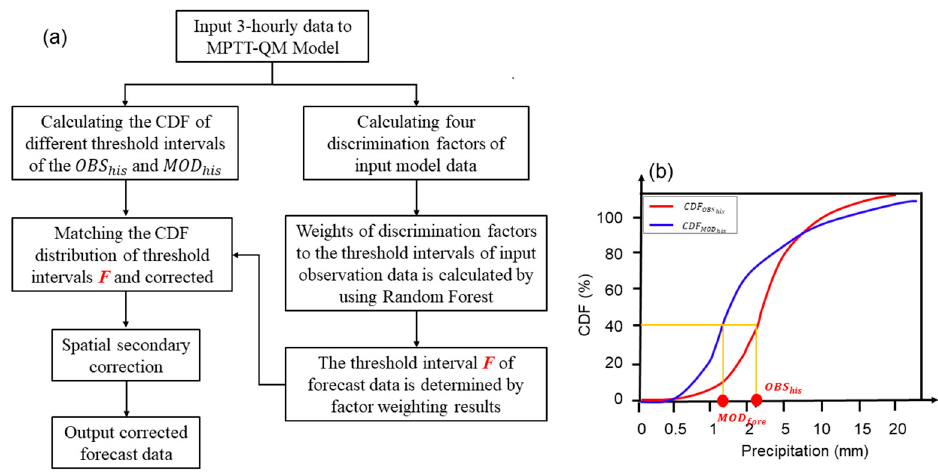
Figure 2. ( a ) The workflow of the MPTT-QM method; and ( b ) the schematic diagram of the QM method. MOD fore represents the forecast model data, OBS his represents the mapped observation data by CDF.